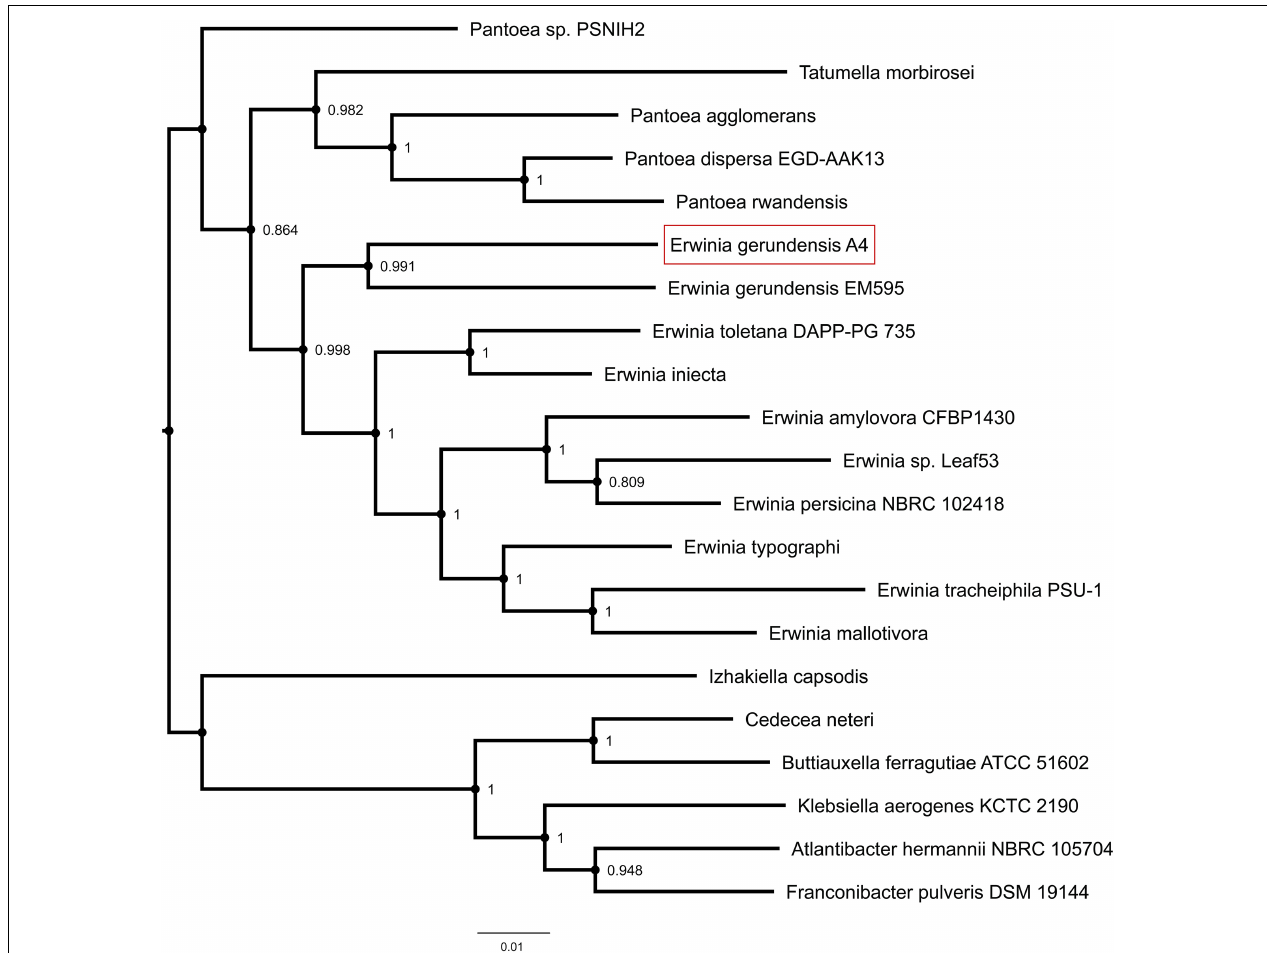
FIGURE 4 | Phylogenetic tree highlighting the position of E. gerundensis strain A4 in comparison to publicly available genomes. Node labels represent confidence levels based on 1,000 bootstrap